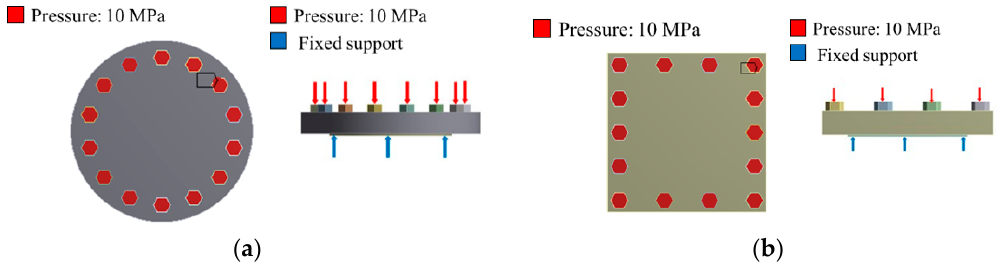
Figure 1. Pressure and fixed support boundary conditions for the ( a ) circular and ( b ) square end plates.